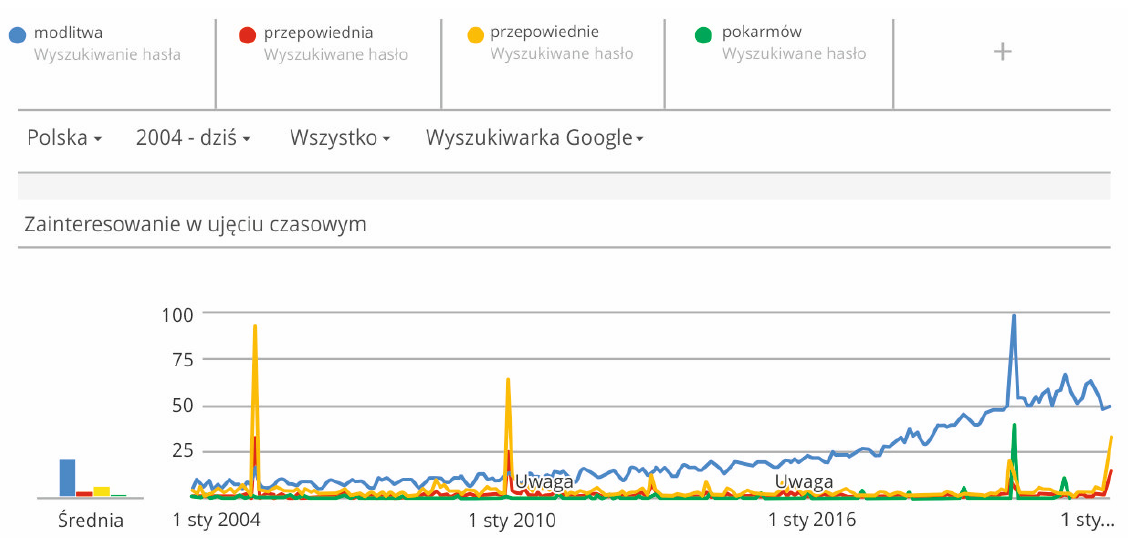
Figure 12. Frequency of searches for the keyword “prophecy” and its linguistic variations over the last five years; source: Google Trends, https://www.google.com/trends (accessed on 23 August 2021).